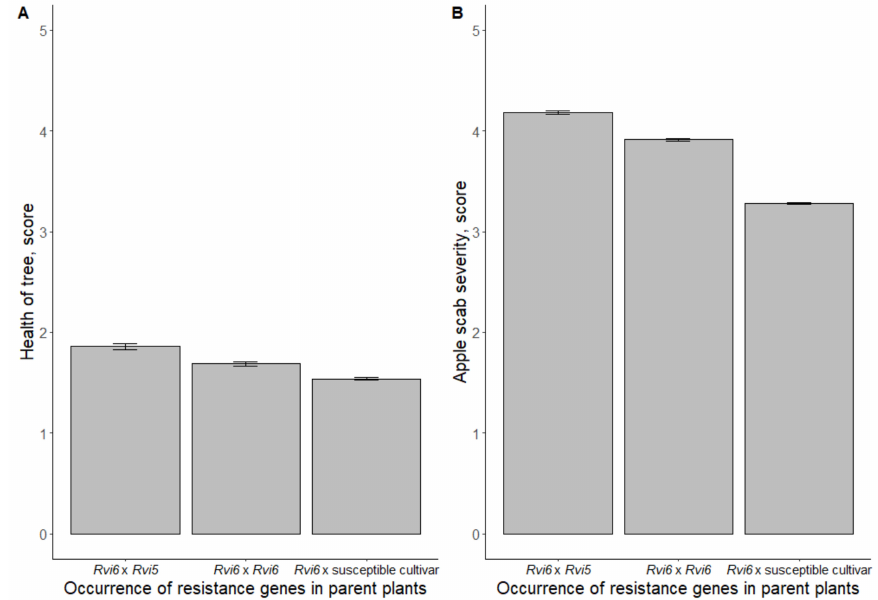
Figure 3. Average health status of trees ( A ) and scab severity ( B ) in apple hybrid seedling populations, grouped according to resistance status of parent